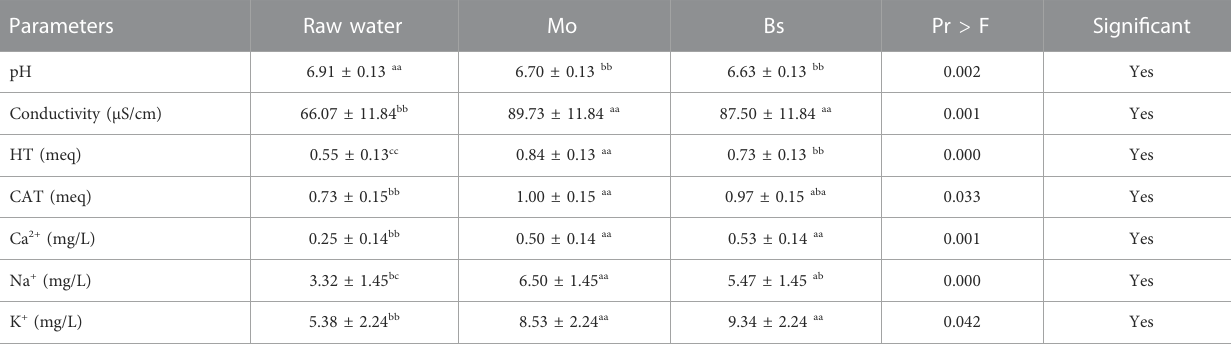
TABLE 2 Physico-chemical parameters of raw water and water samples treated with Moringa oleifera (Mo) and Boscia senegalensis (Bs).